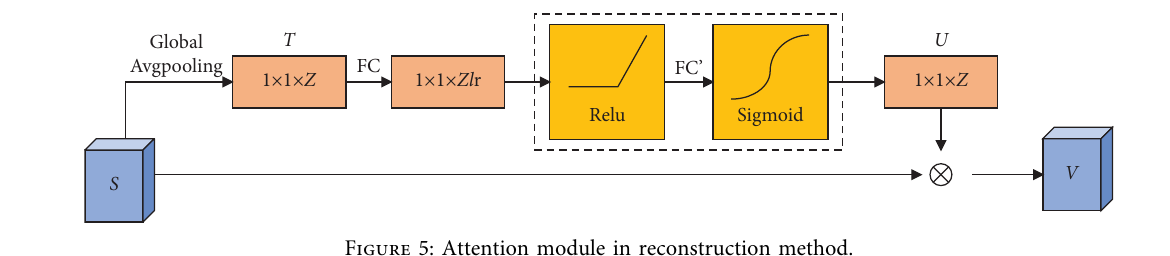
Figure 4: Reconstruction model structure.